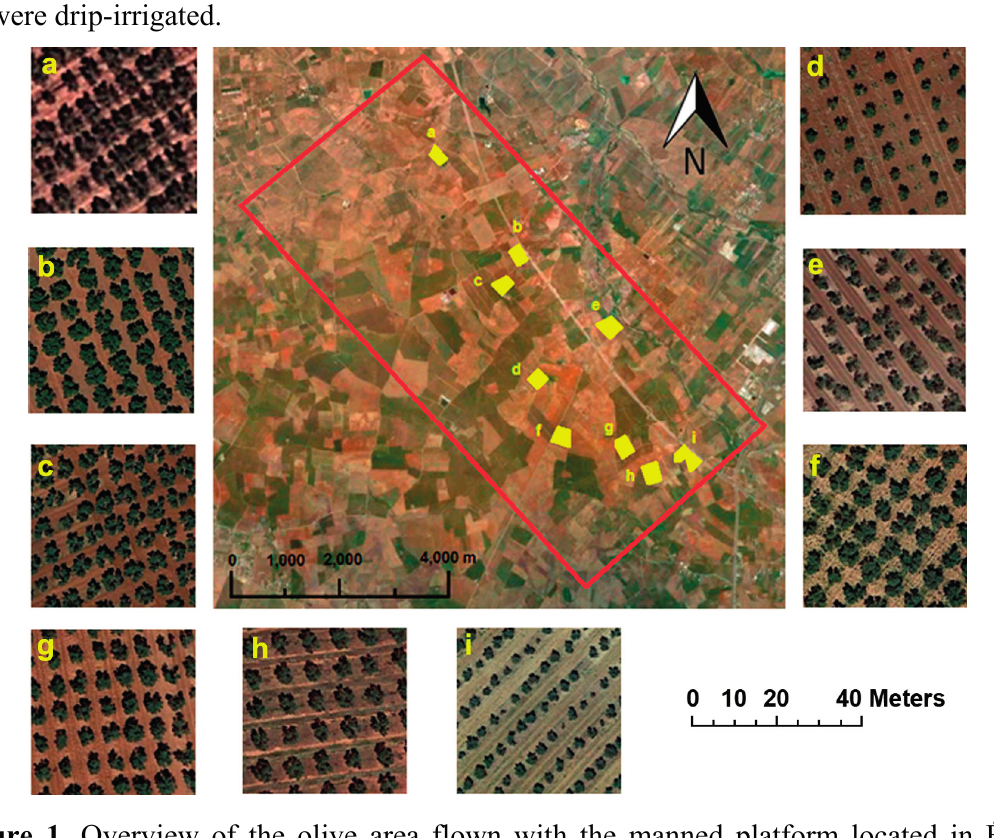
Figure 1. Overview of the olive area flown with the manned platform located in Écija (Seville province). Verticillium wilt severity was assessed in the plots which are shown in yellow. High-resolution detail of each individual olive plot assessed in this study was shown with lettering ( a–i ) in agreement with the plot lettering ( a–i ) in central image. Note differences in soil and crop management among